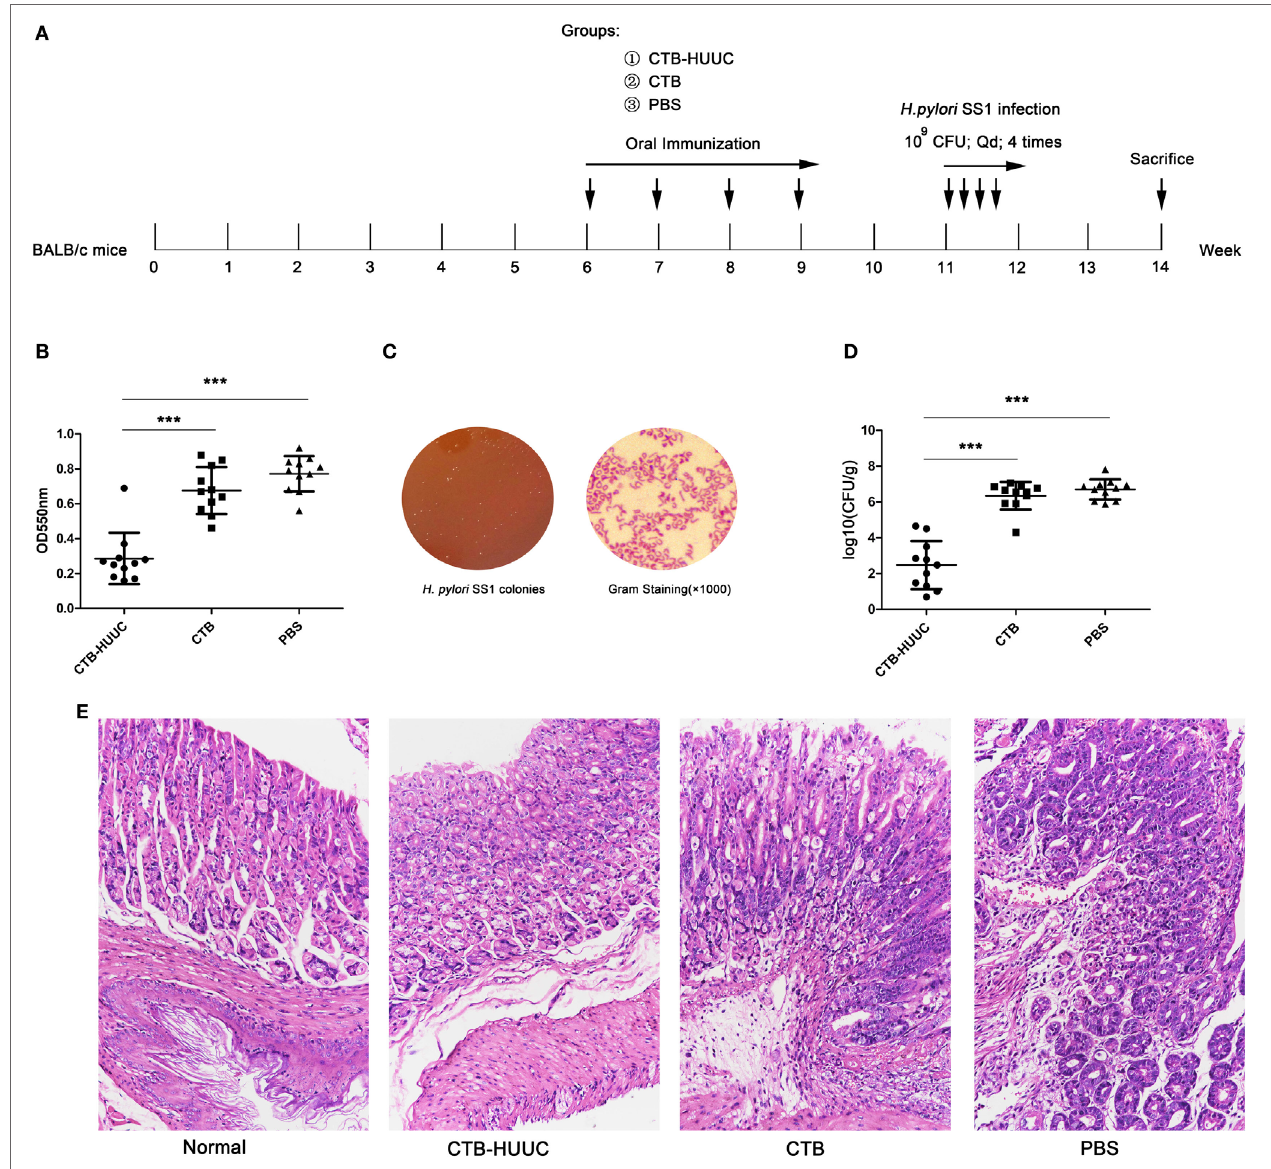
FigUre 5 | The effects of prophylactic vaccination with cholera toxin B subunit (CTB)-HUUC or CTB on Helicobacter pylori infection. (a) The prophylactic vaccination procedure. (B) The relative levels of urease activity in the stomach of mice infected by H. pylori after prophylactic oral immunization. *** p < 0.001, compared with the PBS group or between the CTB-HUUC and CTB groups. (c) Representative view of the H. pylori culture for colony formation assay. (D) The colony-forming units (CFUs) of H. pylori infection in the stomach of mice after prophylactic oral immunization. H. pylori infection was determined using quantitative culture. Abbreviation: CFU, colony-forming unit. *** p < 0.001, compared with the PBS group or between the CTB-HUUC and CTB groups. (e) Gastric histological examination of mice infected by H. pylori after prophylactic oral immunization. The gastric tissue samples stained with hematoxylin and eosin were examined under a microscope (200 ×